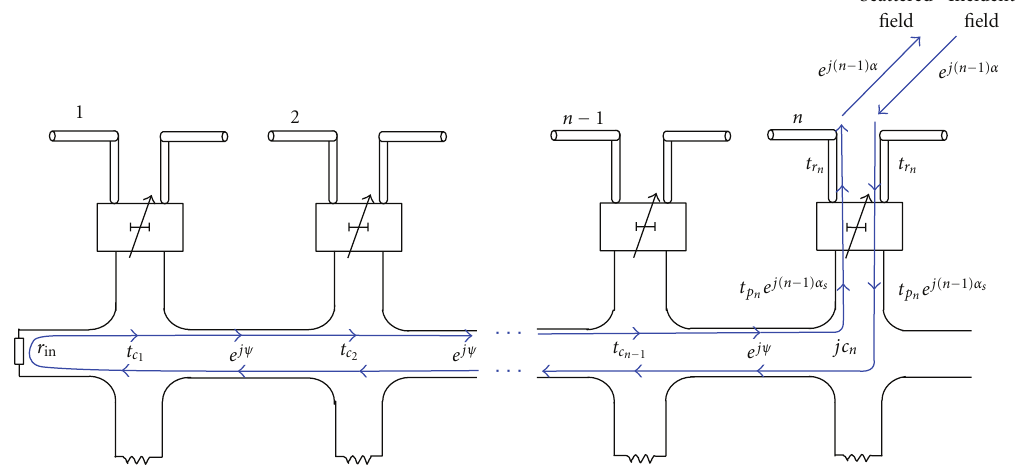
Figure 11: Path of the signal travelling towards the load terminating the input port.